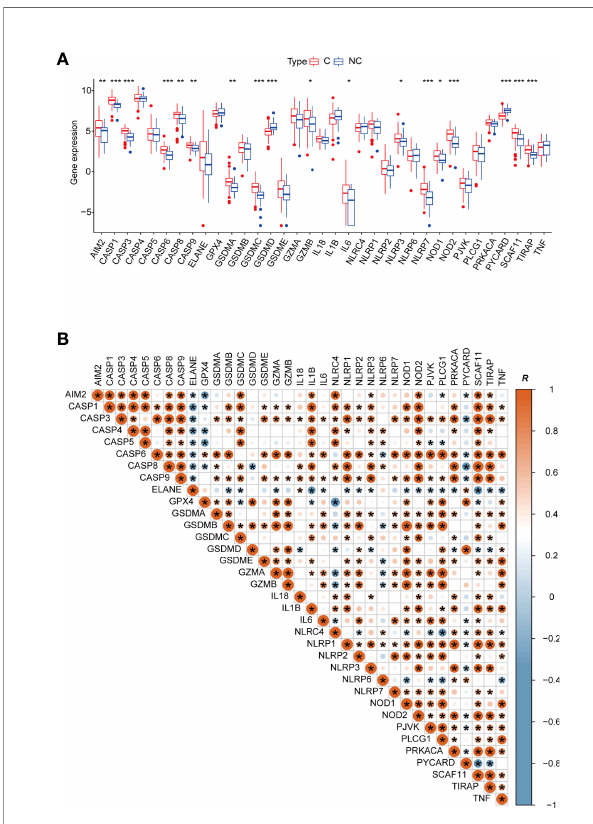
FIGURE 1 | (A) Boxplot of 35 pyroptosis-related genes ’ relative expression between different types of patients. C: COVID-19 patients; NC: none-COVID- 19 patients. (B) The Pearson ’ s correlation between 35 pyroptosis-related genes in COVID -19 patients, R value represents the Pearson ’ s correlation coef fi cient. *p < 0.05, **p < 0.01, ***p < 0.001, ****p <